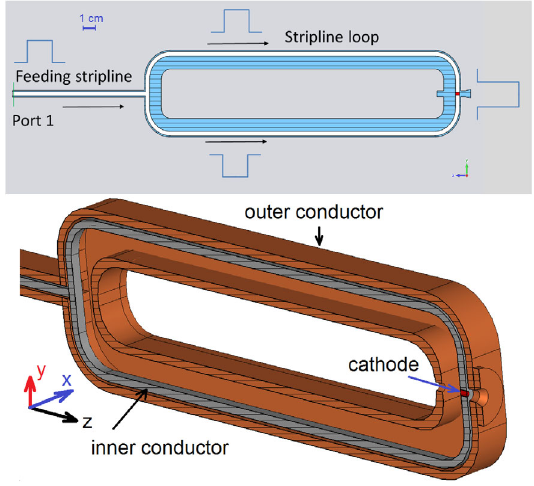
FIG. 2. On top, a 2D cross-sectional — in the electron bunch plane — drawing of the symmetrical stripline-loop based cathode configuration. The inner conductor and vacuum region are depicted in white and blue, respectively. The cathode is sche- matically shown by the red rectangle located in the inner conductor. On bottom, a cross-sectional drawing of the stripline- loop in perspective.